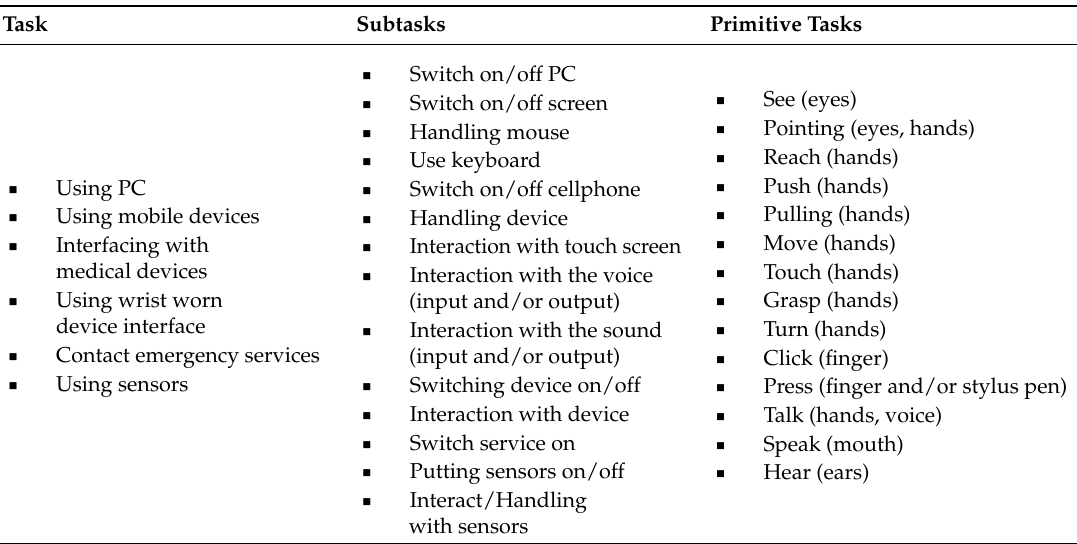
Table 3. Affected tasks, subtasks and primitive